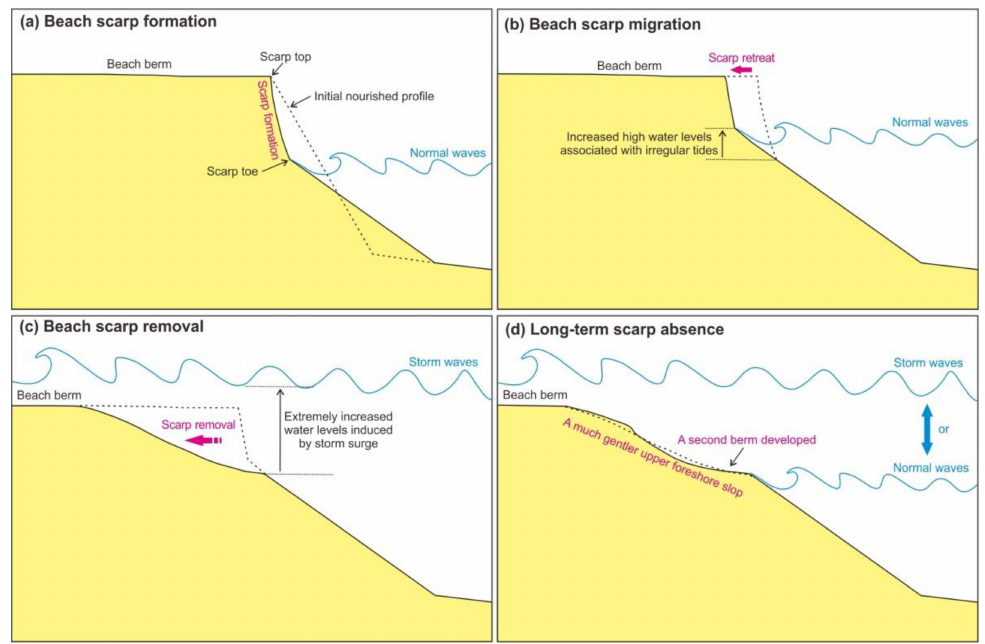
Figure 11. Four phases of beach scarp evolution for a nourished beach in low-energy and micro-tidal environment; beach scarp formation ( a ), beach scarp migration ( b ), beach scarp removal ( c ), and long-term scarp absence ( d